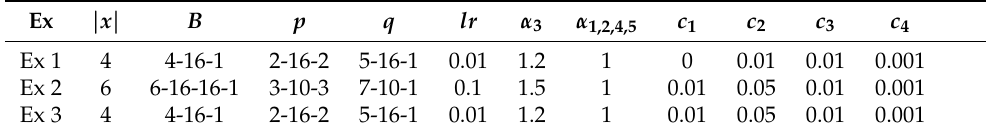
Table 1. Performance